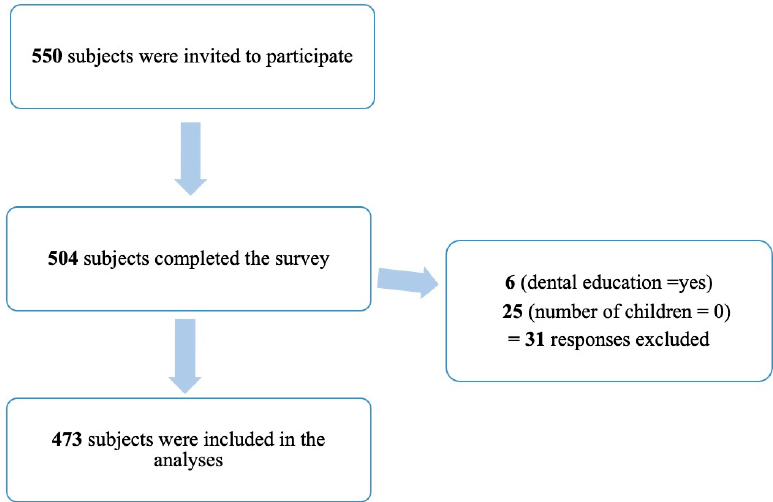
Figure 1. Data collection flow chart. Numbers represent the number of subjects. Table 1. Demographics of survey participants (N =